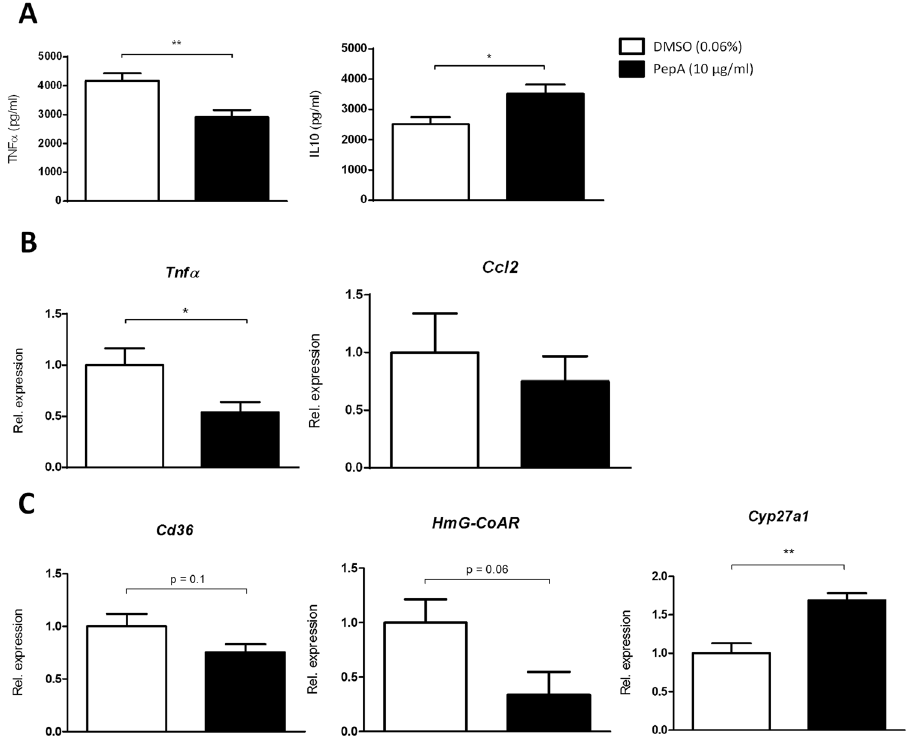
Figure 5. Gene expression and cytokine levels of oxLDL-loaded bone marrow-derived macrophages (BMDM) treated with PepA. ( A ) TNF α and IL10 cytokine secretion in supernatant of Wt mouse BMDMs, exposed to oxLDL for 24 hr and, subsequently, treated with or without PepA (4 hr) and LPS (4 hr). ( B,C ) Gene expression analysis of Tnf α , Ccl2, Cd36, HmG-CoAR and Cyp27a1 measured in Wt mouse BMDMs. Gene expression data are shown relative to DMSO-treated BMDMs. All data represent the mean value of three or four independent experiments (with n = 13-16 per group). Error bars represent ± SEM; * indicates p ≤ 0.05, ** p < 0.01 and *** p < 0.001 compared to DMSO-treated bone marrow-derived macrophages by use of two-tailed unpaired t